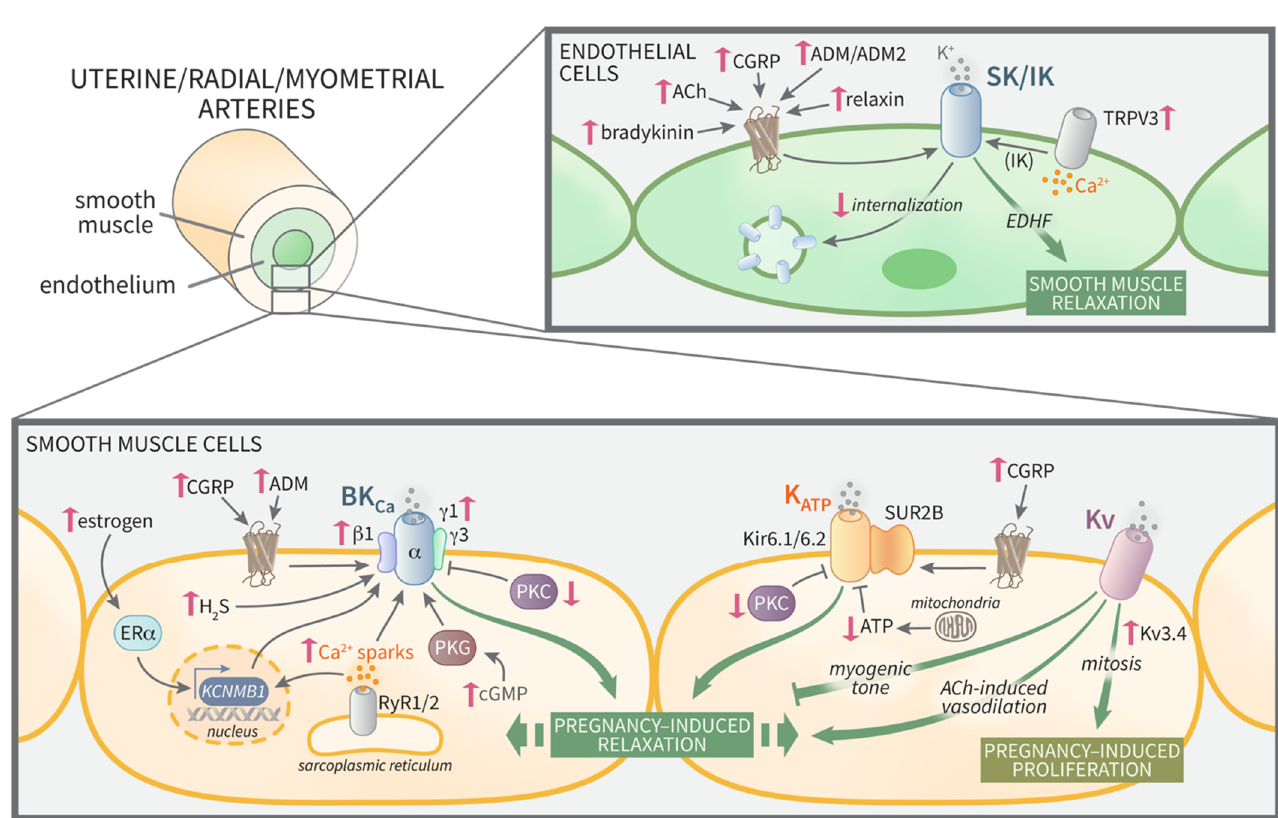
Figure 1. Mechanisms underlying the modulation of K + channels in the uterine vasculature during normal pregnancy. Pregnancy increases uterine blood flow by augmenting vasodilation and/or remodeling of uterine, radial, and myometrial arteries. A critical mechanism for increased vasodilation is greater activation of K + channels in the endothelium ( top panel ) and smooth muscle ( bottom panel ) of these uterine blood vessels. Pink arrows show the effects of pregnancy. ACh, acetylcholine; ADM, adrenomedullin; ADM2, adrenomedullin 2; ATP, adenosine triphosphate; BK Ca , large-conductance Ca 2+ -activated K + channel; β 1, BK Ca β 1 subunit; cGMP, cyclic guanosine monophosphate; CGRP, calcitonin gene-related peptide; EDHF, endothelial-derived hyperpolarizing factor; ER α , estrogen receptor α ; γ 1 and γ 3, BK Ca γ 1 and γ 3 subunits; H 2 S, hydrogen sulfide; IK, intermediate-conductance Ca 2+ -activated K + channel; K ATP , ATP-sensitive K + channel; KCNMB1 , BK Ca β 1 subunit gene; Kir6.1/6.2, inward-rectifier K + channel type 6.1 and 6.2; Kv, voltage-gated K + channel; Kv3.4, voltage-gated K + channel type 3.4; PKC, protein kinase C; PKG, protein kinase G; RyR1/2, ryanodine receptor type 1 and 2; SK, small-conductance Ca 2+ -activated K + channel; SUR2B, sulfonylurea receptor type 2B; TRPV3, transient receptor potential vanilloid type